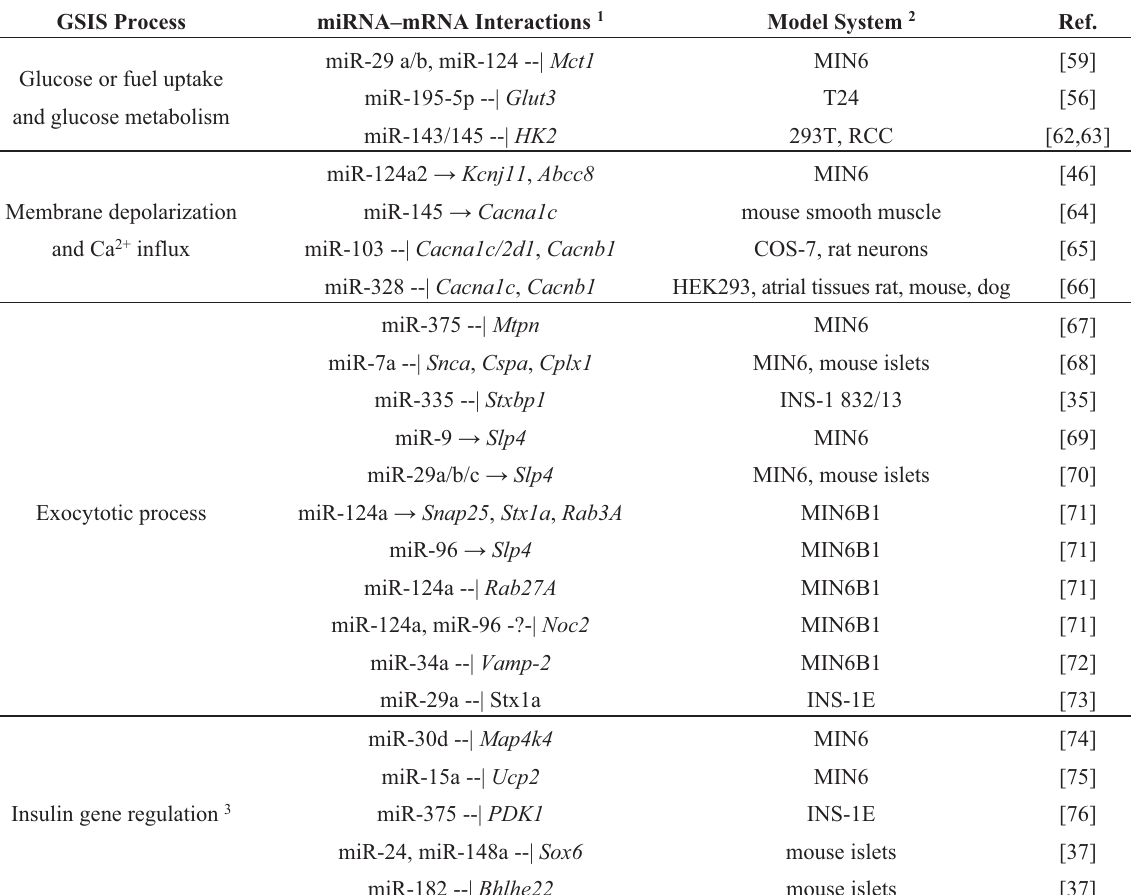
Table 1. miRNAs implicated in regulating components of glucose-stimulated insulin